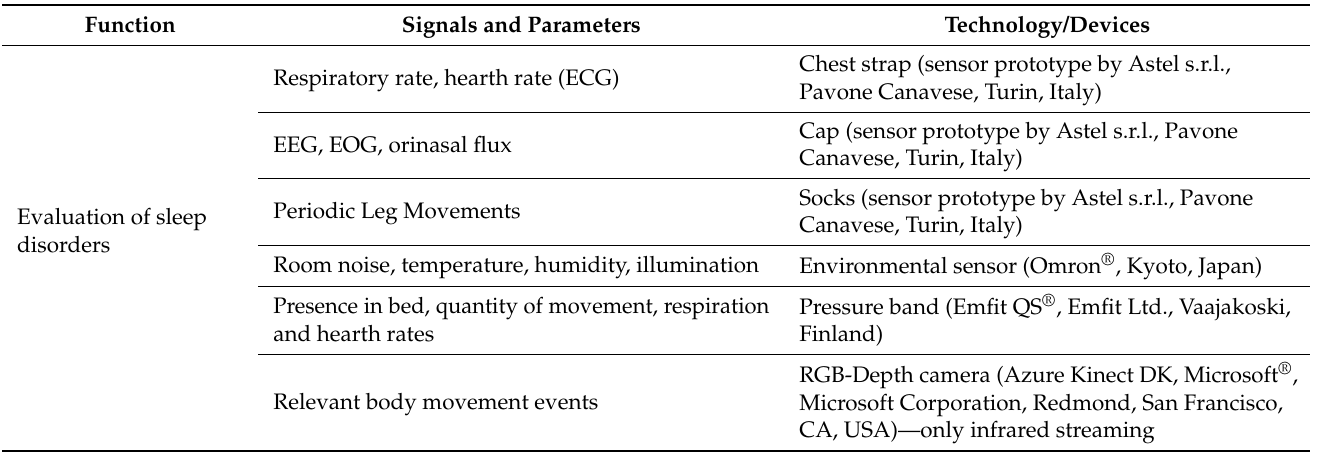
Table 3. Summary of the main signals monitored by